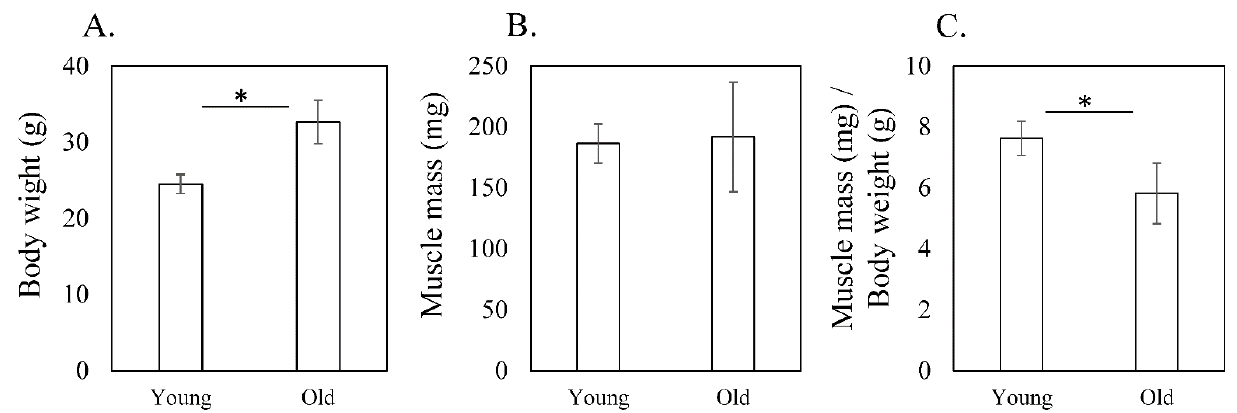
Figure 1. Muscle mass of the quadriceps of young and old mice. ( A ) Body weight (g), ( B ) muscle mass (mg), and ( C ) muscle mass (mg)/body weight (g) in young (3-month-old) and old (24-month-old) mice. Body weight was significantly higher in old mice than in young mice ( p < 0.001; ( A )). Muscle mass did not significantly differ between young and old mice ( p = 0.481; ( B )). However, muscle mass/body weight was significantly lower in old mice than in young mice ( p < 0.001; ( C )). Data are expressed as the mean ± standard deviation (SD). Asterisks indicate p <